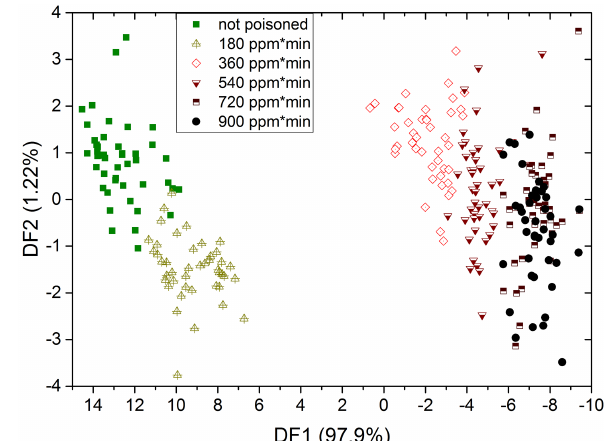
Figure 9. LDA plot showing the discrimination of different poi- soning states based on data acquired during air exposure. The 12 features used for this LDA are based on linear fits of the non- normalized conductance values during the same intervals which were also used for gas discrimination (cf. Fig.